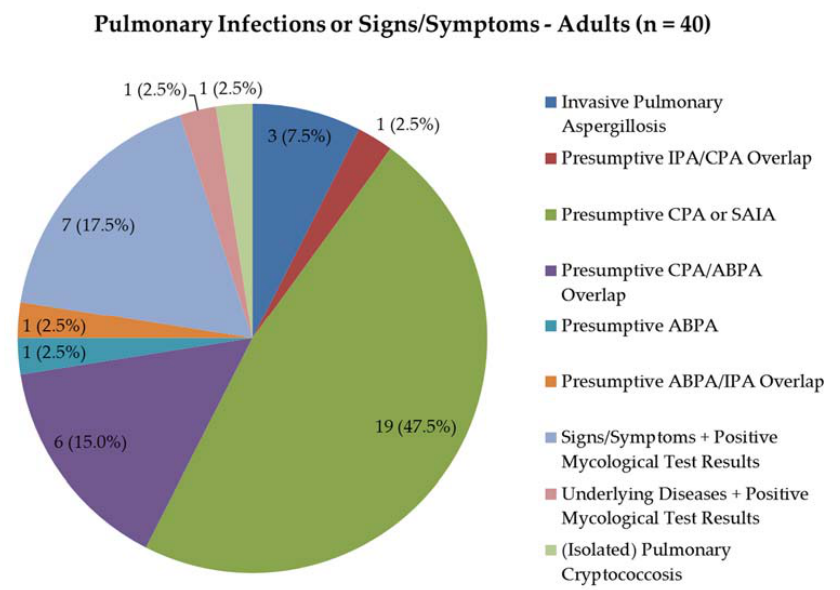
Figure 3. Pulmonary infections or signs / symptoms in adults. Data represent the presumptive